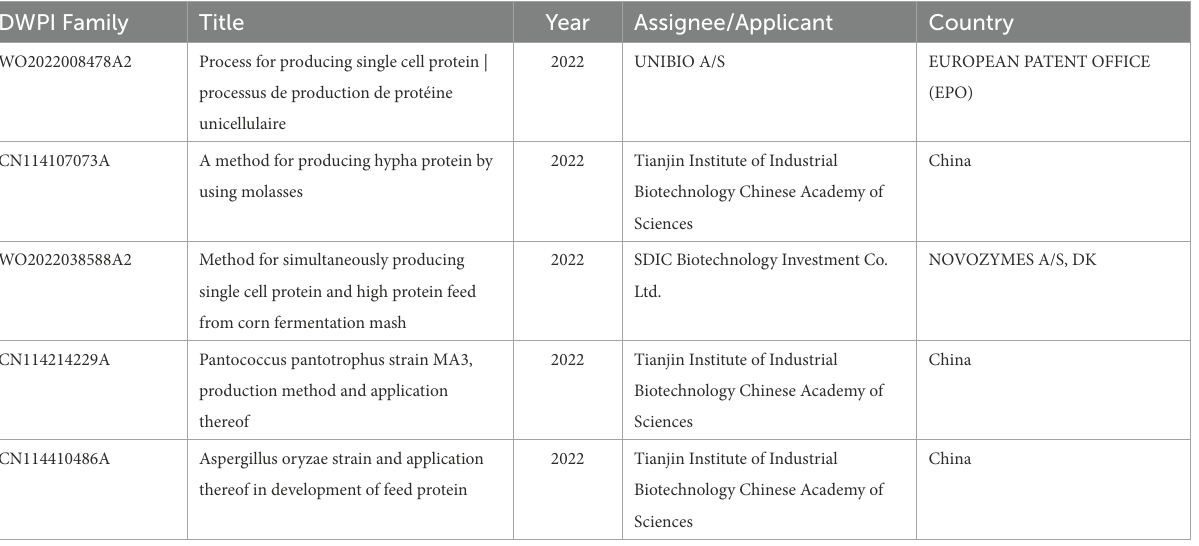
TABLE 1 Patents on single cell protein submitted in 2022.